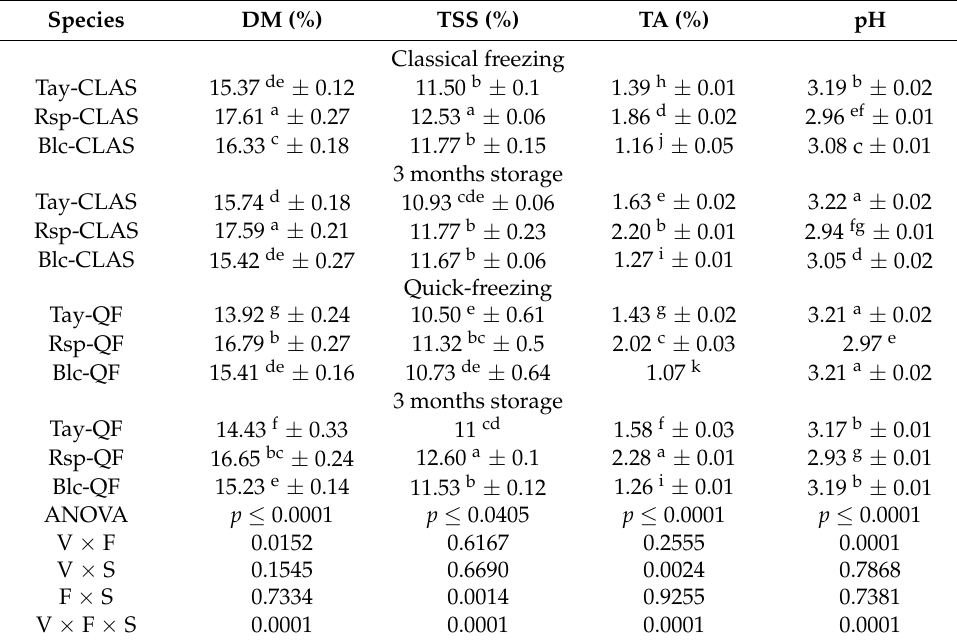
Table 5. Physicochemical properties of frozen berry